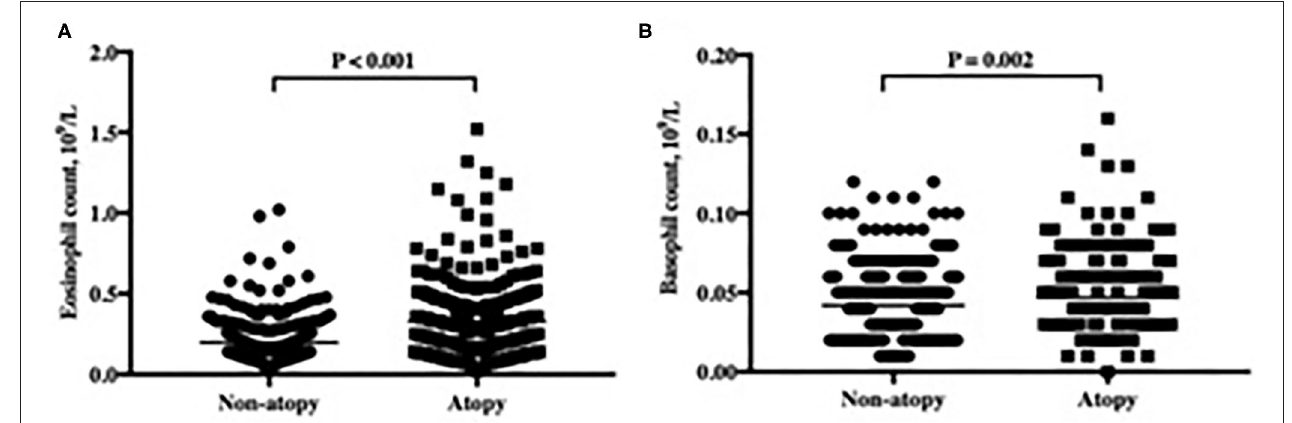
FIGURE 3 | The counts of eosinophil (A) and basophil (B) in atopic and non-atopic subjects.